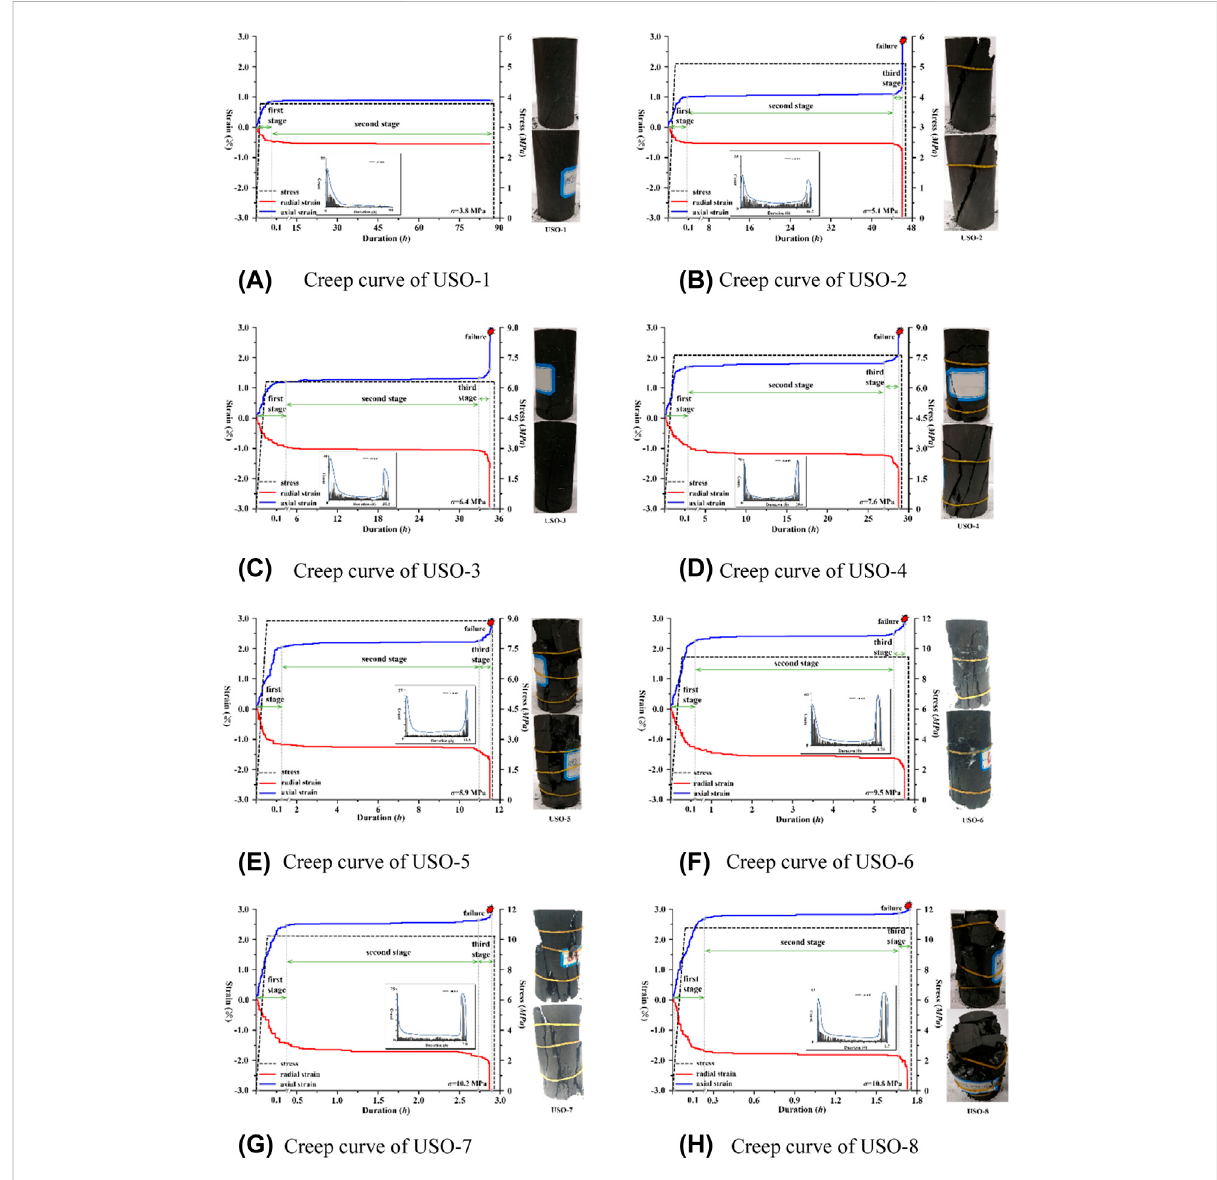
FIGURE 5 Laboratory fi ndings of USO group